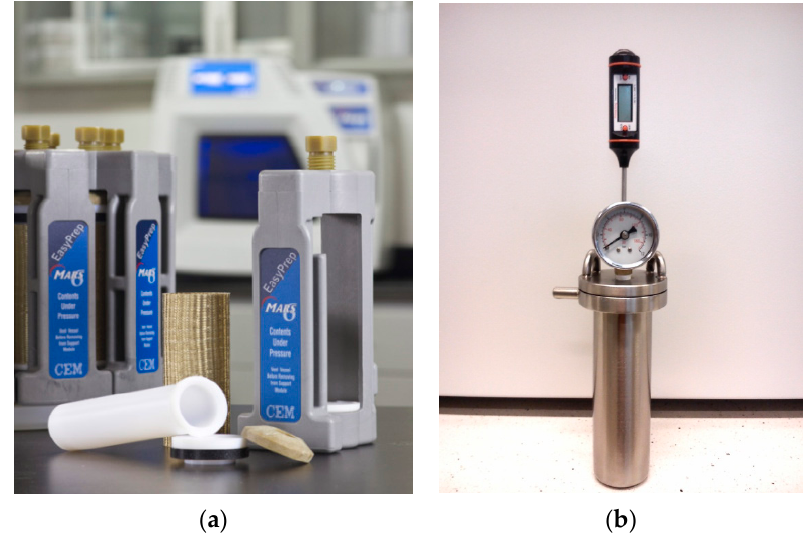
Figure 1. ( a ) Easy Prep Teflon vessels and ( b ) own-design thermal reactor.